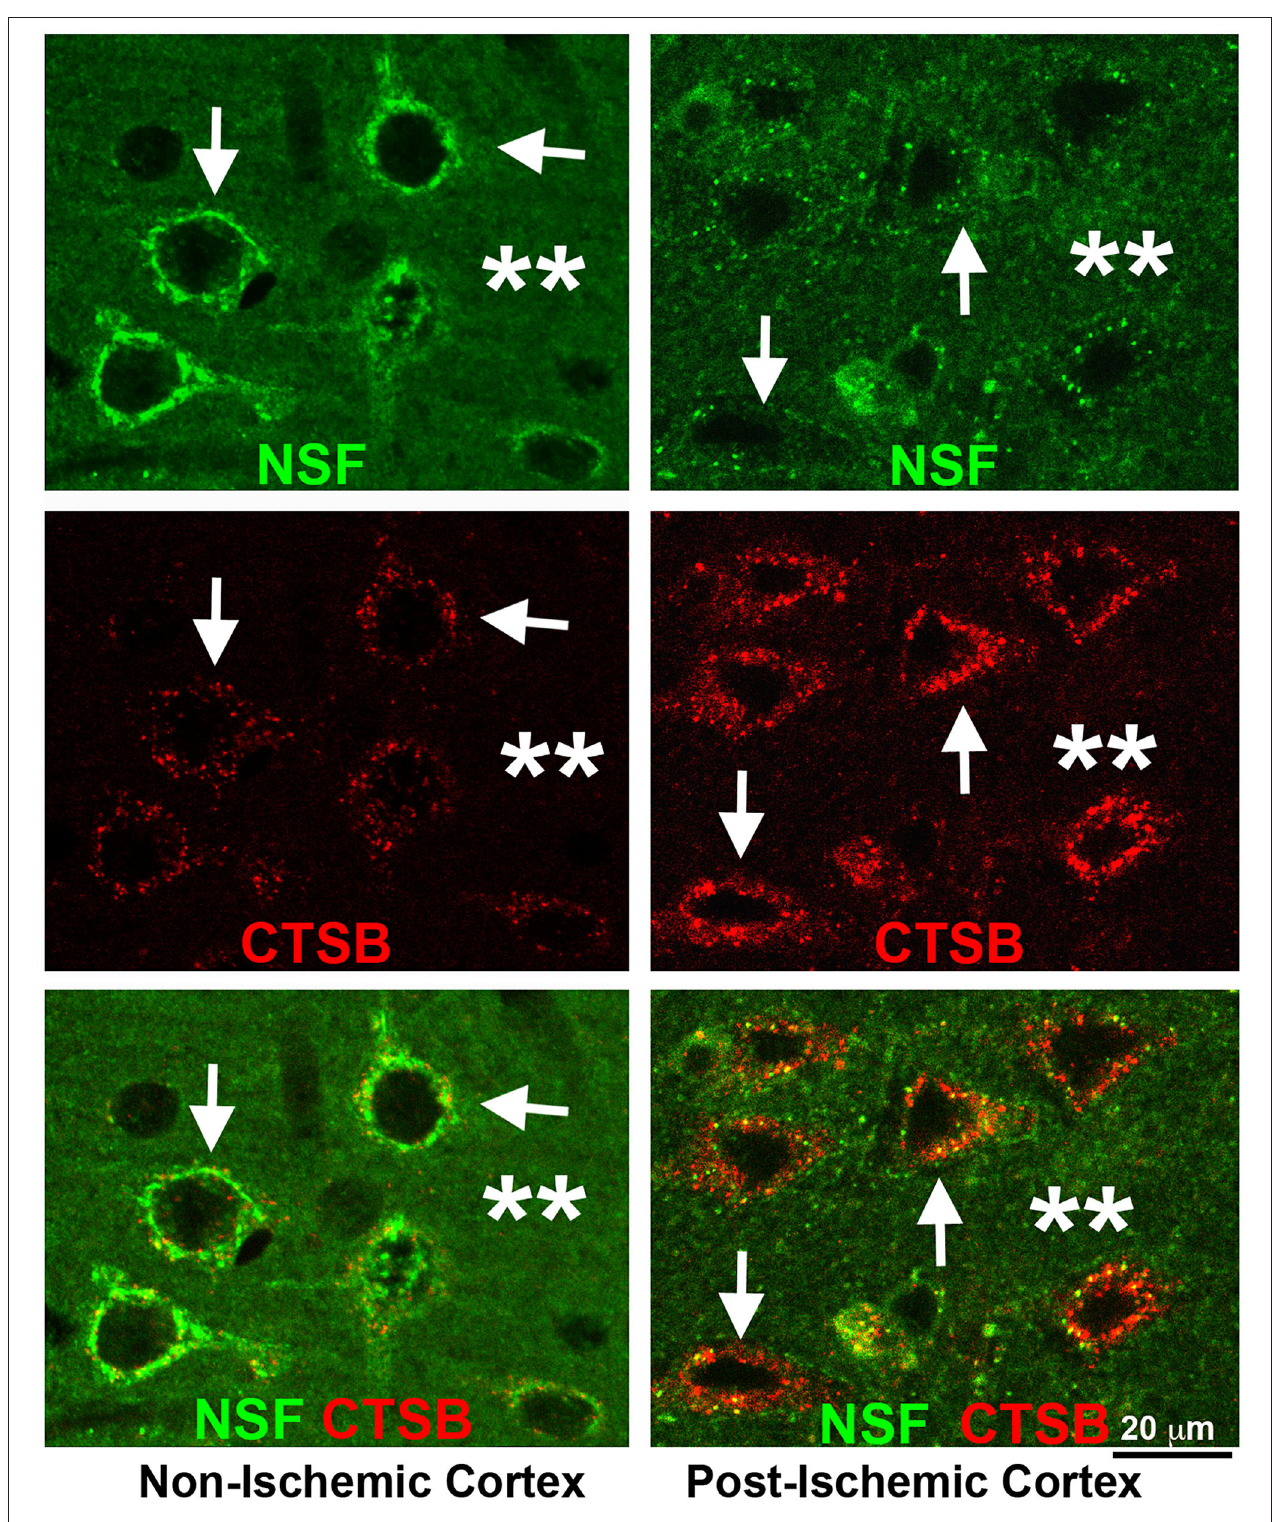
FIGURE 3 | Confocal imaging of neuronal NSF depletion and CTSB buildup after stroke. Brain section obtained from a rat subjected to 2h of MCAO followed by 24h of reperfusion, double-labeled with NSF (green) and CTSB (red) antibodies, and examined by confocal microscopy. Left panels display the non-ischemic contralateral neocortex; Right panels show the post-ischemic ipsilateral neocortex. Upper row: NSF immunolabeling; Middle row: CTSB immunolabeling; Lower row: NSF (green) and CTSB (red) double-immunolabeling. Arrows point to neuronal soma; and stars denote the immunostaining outside neuronal soma.